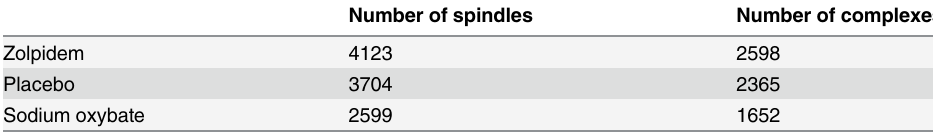
Table 1. Numbers of spindles and spindle/SO complexes across different drug conditions. Number of spindles Number of complexes Zolpidem